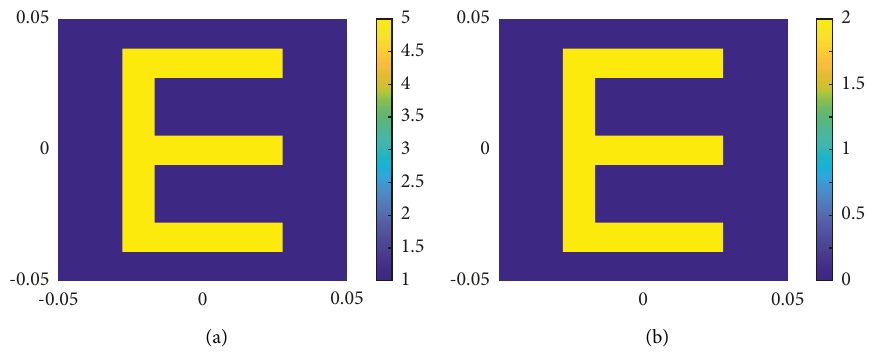
Figure 9: Original relative permittivity distribution. (a) Real part. (b) Imaginary